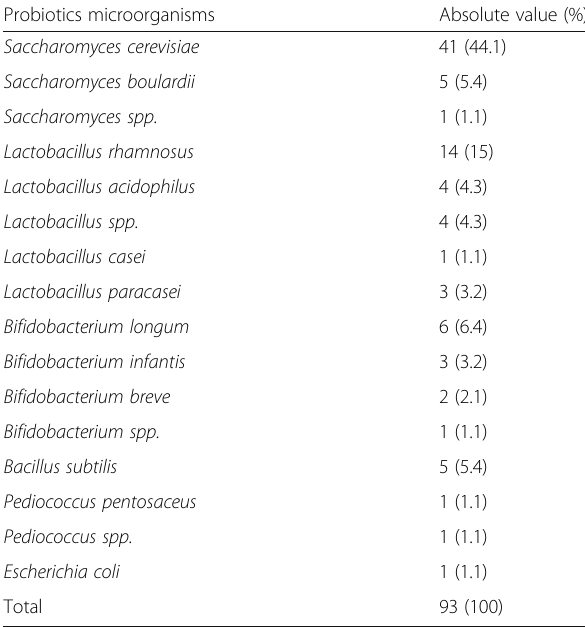
Table 1 Etiology of infectious complications after use of probiotics in 93 patients identified by systematic review, 1976 – 2018 Probiotics